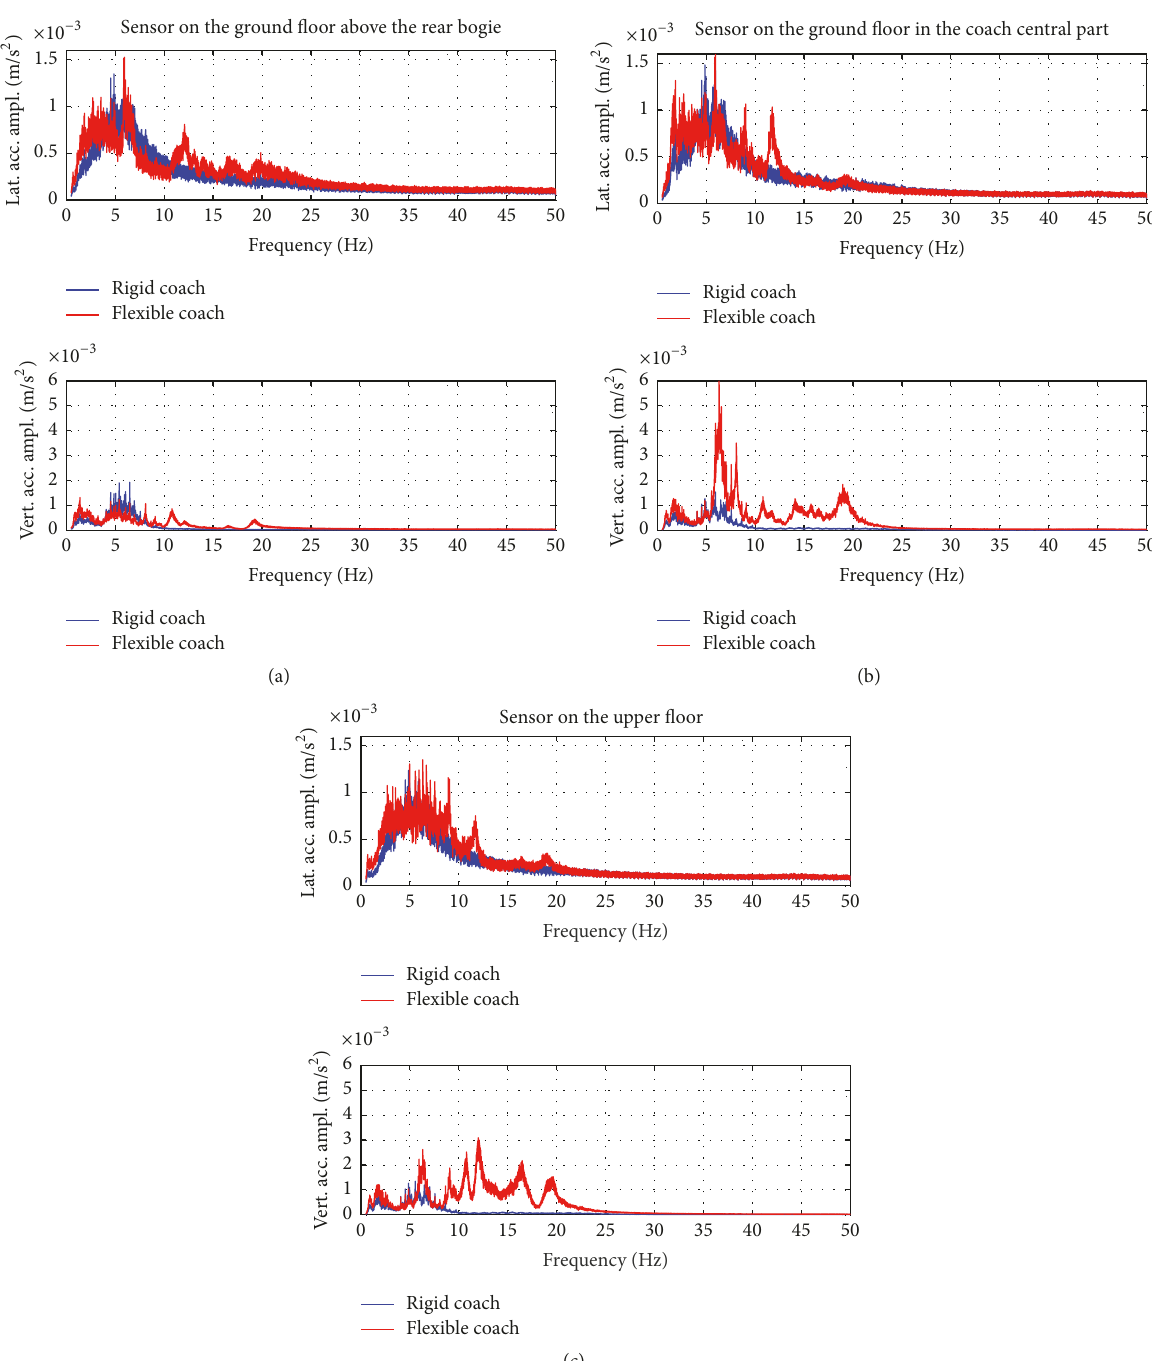
Figure 23: Amplitude of the lateral and vertical acceleration measured on different points of the coach.